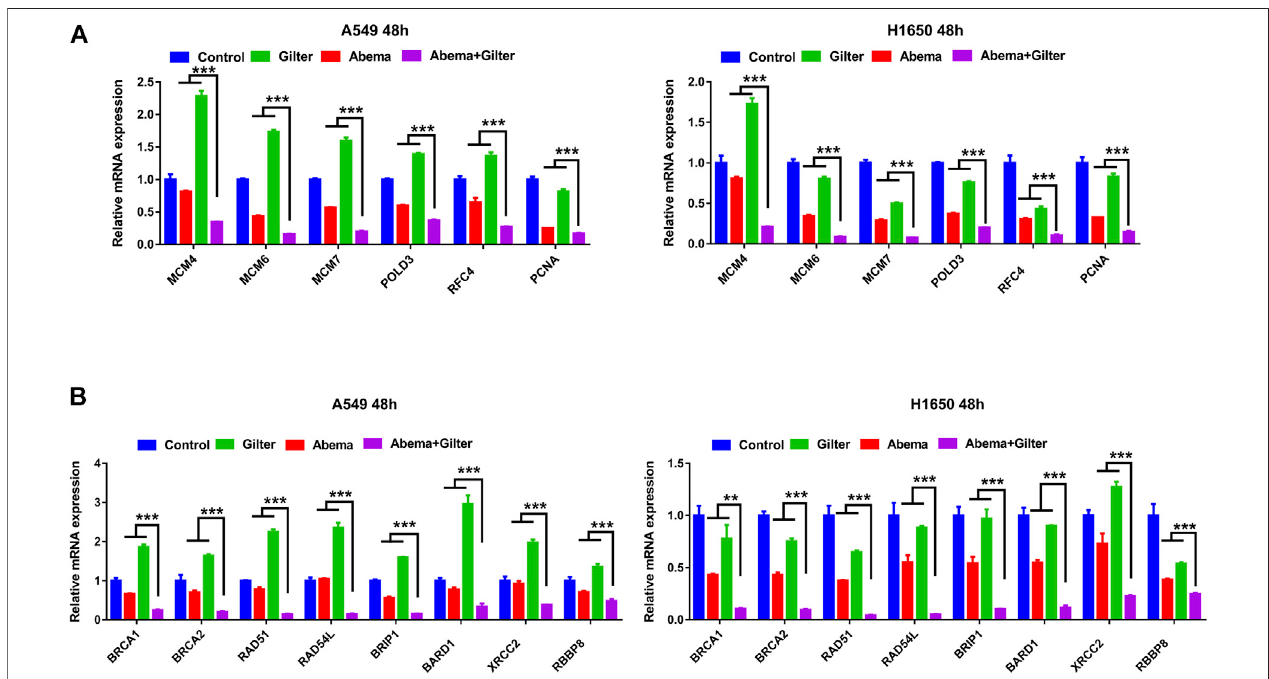
FIGURE 6 | Abemaciclib in combination with gilteritinib inhibits DNA replication, HR associated gene expression (A) A549 and H1650 cells were treated by 1 μ M abemaciclib alone, or 150 nM gilteritinib alone, or their combination for 48 h, and the expressions of DNA replication genes, including MCM4, MCM6, MCM7, POLD3, RFC4 and PCNA were determined by qRT-PCR (B) A549, H1650 cells were treated by 1 μ M abemaciclib alone, or 150 nM gilteritinib alone, or their combination for 48 h, and the mRNA expressions of HR pathway gene, including BRCA1, BRCA2, RAD51, RAD54L, BRIP1, BARD1, XRCC2, RBBP8 were determined by qRT- PCR. Data are representative of three independent experiments. ** p < 0.001. *** p < 0.0001.